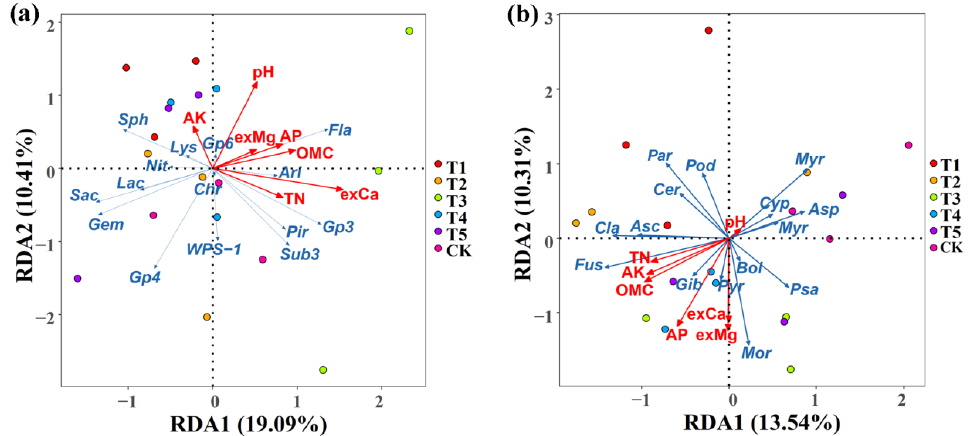
Figure 8. Redundancy discriminant analysis (RDA) of the rhizosphere bacterial ( a ) and fungal ( b ) community compositions at the genus level with the soil physicochemical properties. Sph: